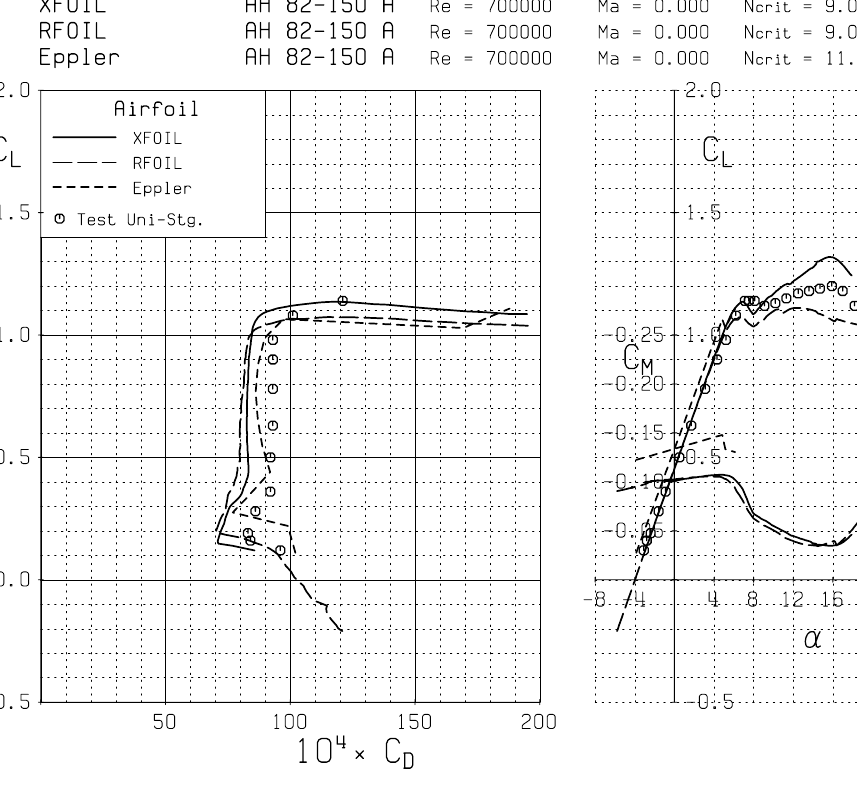
Fig 9. Comparison of calculated and measured data of AH82-150A airfoil at Re = 0.7·10 6